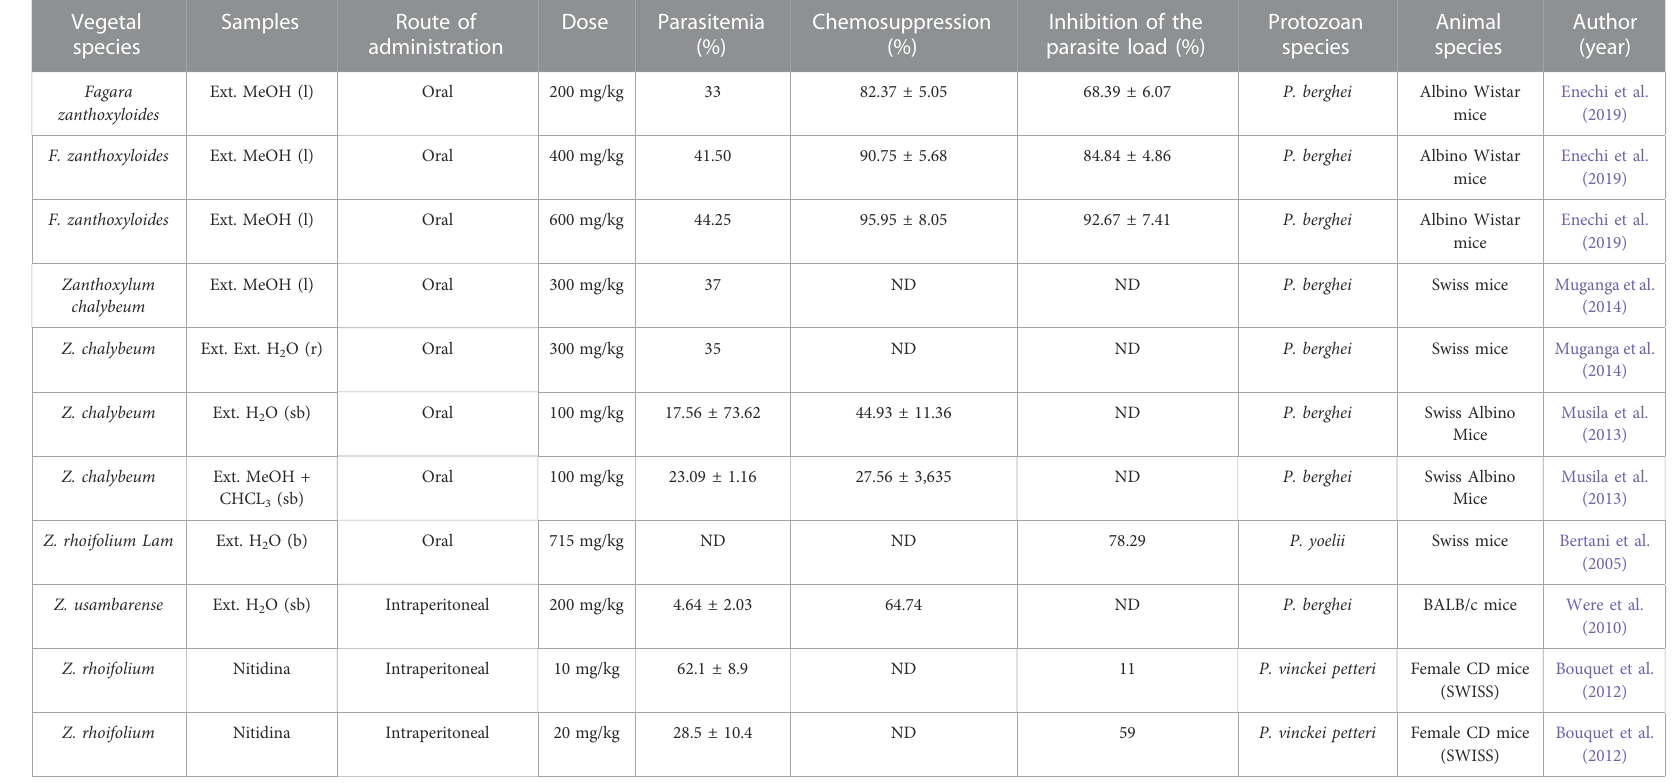
TABLE 4 In vivo antiparasitic activity against